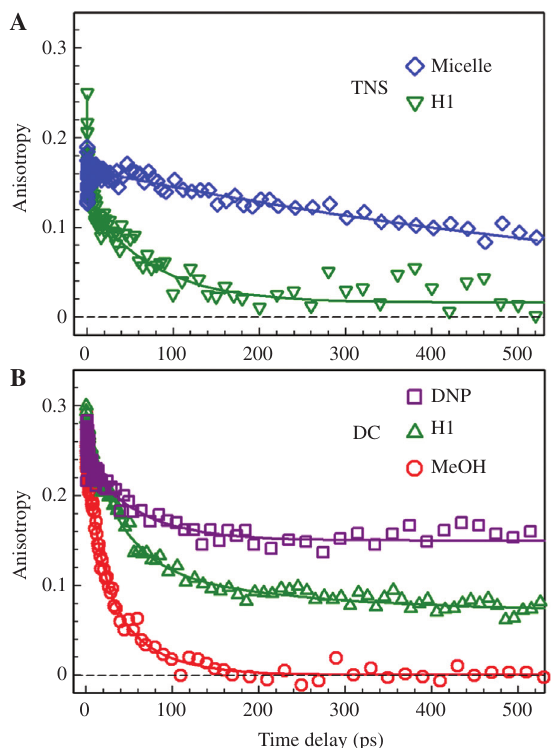
Figure 7 Femtosecond-resolved fluorescence anisotropy in differ- ent environments for (A) TNS (micelle, H1) and (B) DC (and DNP, H1, MeOH) at the peak